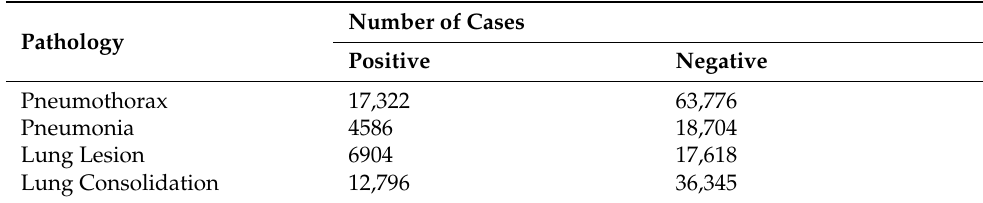
Table 1. Number of patients after segmentation.